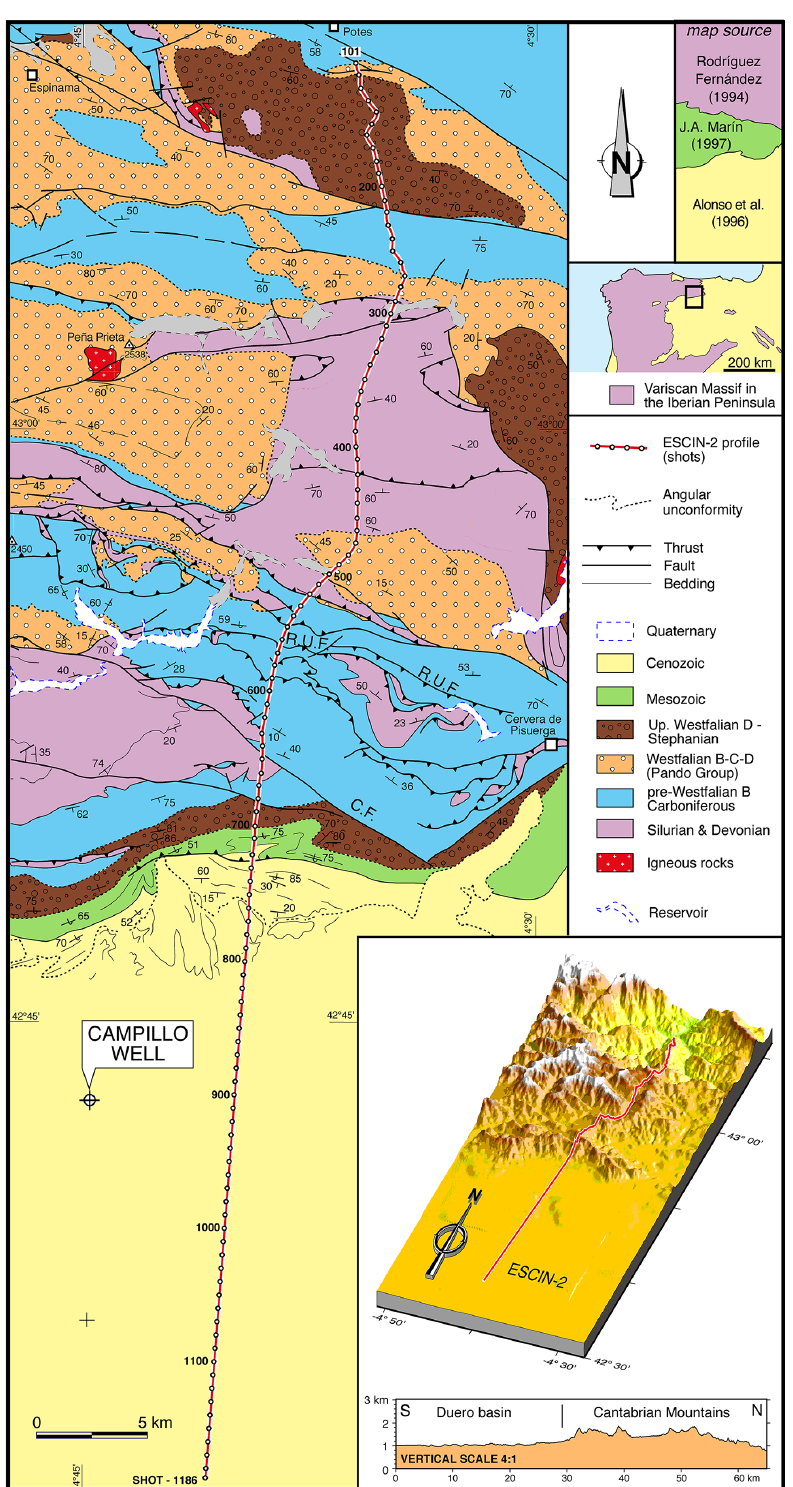
Figure 3. Geological map of the studied area. The inset box in the lower right-hand corner shows a 3-D DTM view of the region and the elevations profile along ESCIN-2 that shows the flat topography in the Duero basin in contrast with the rugged mountainous terrain in the Cantabrian Mountains. Geological map compiled from Rodríguez-Fernández (1994), Alonso et al. (1996) and Marín (1997).